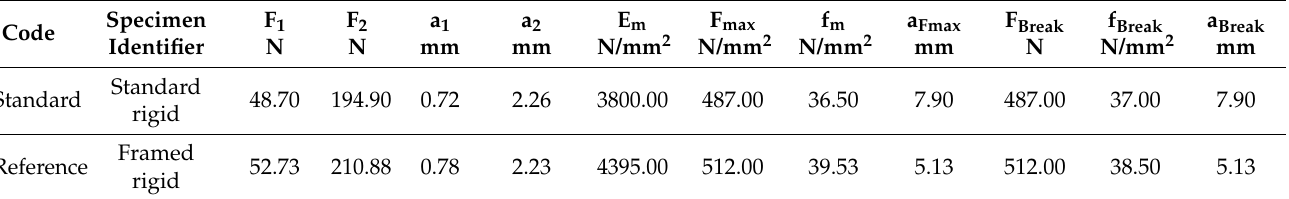
Table 2. Results of static bending (mean values) for standard and framed rigid samples.